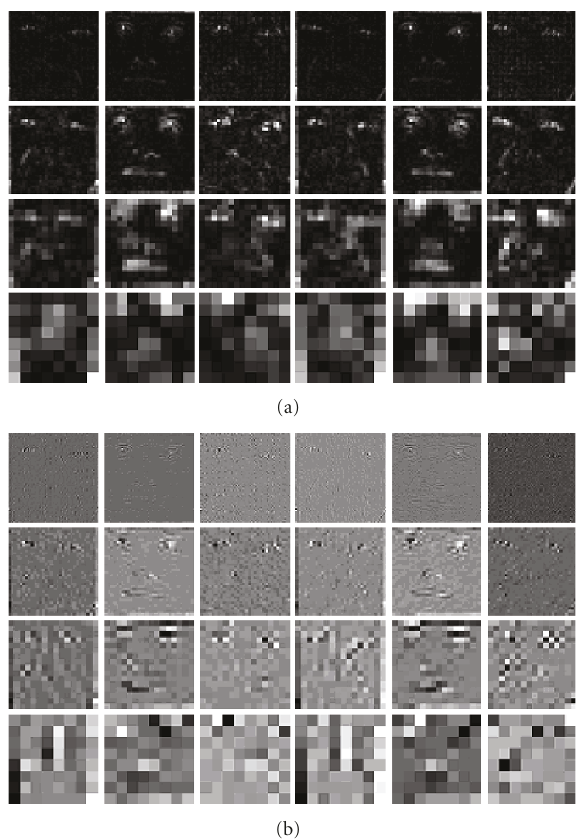
Figure 6: DT-CWT transformation of a sample image (top left face in Figure 12). (a) The magnitude of the transformation. (b) The real part of the transformation.